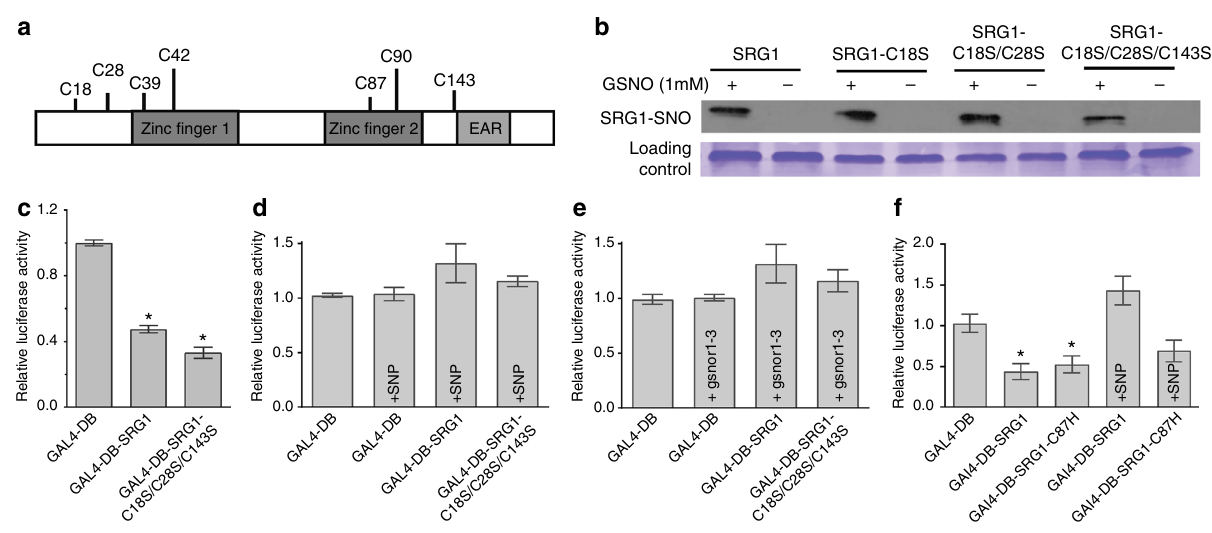
Fig. 5 S -nitrosylation of target SRG1 cysteine residues. a Schematic representation of SRG1 showing its predicted functional domain structure and the location of cysteine (Cys) residues. b Impact of combined mutations of SRG1 Cys residues outside of the zinc fi nger (ZF) domains on the S -nitrosylation status of SRG1. c Impact of combined mutations of SRG1 Cys residues outside of the ZF domain on the transcriptional repression activity of SRG1 in an srg1 genetic background. Error bars mean ± SD ( n = 3). Asterisks indicate signi fi cant difference relative to GAL4-DB ( t -test, * P < 0.05). d , e The impact of the nitric oxide (NO) donor SNP (1 mM) ( d ) and increased S -nitrosoglutathione (GSNO) accumulation in a srg1 gsnor1-3 genetic background ( e ) on the transcriptional repression activity of wild-type (WT) and a triple SRG1 mutant carrying mutations in all Cys residues outside of the ZF